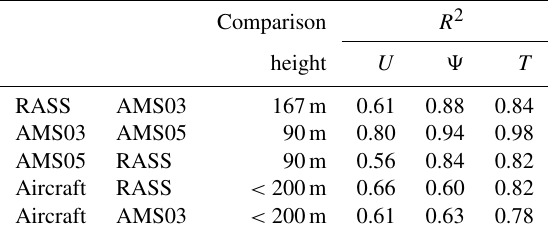
Table 2. Correlation coefficient ( R 2 ) of wind speeds ( U ), wind di- rections ( (cid:57) ), and temperature ( T ) at given comparison